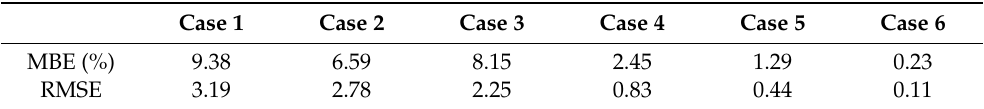
Table 5. Results of MBE and RMSE statistics of calculation results according to the ventilation rate and infiltration